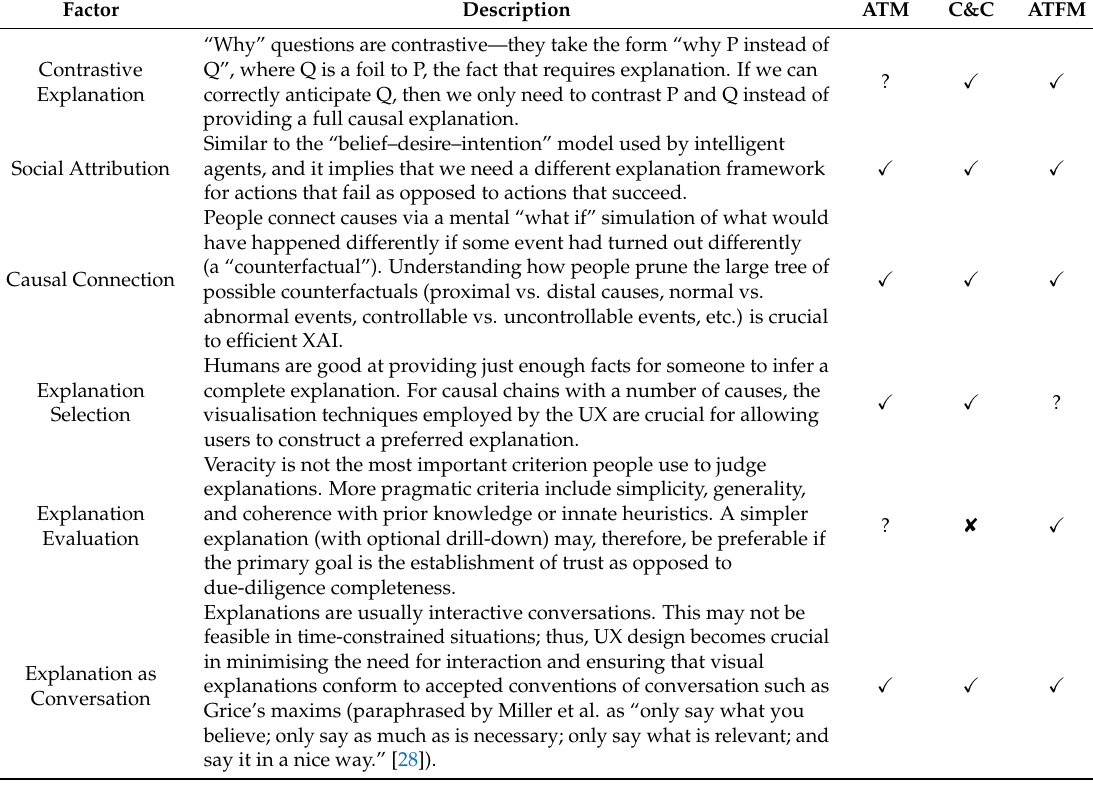
Table 4. Some considerations for the user mental model (after Reference [28]). ATM—air traffic management; C&C— command & control; ATFM—air traffic flow management; XAI—explainable artificial intelligence; UX—user interface design. Factor Description ATM C&C ATFM Contrastive